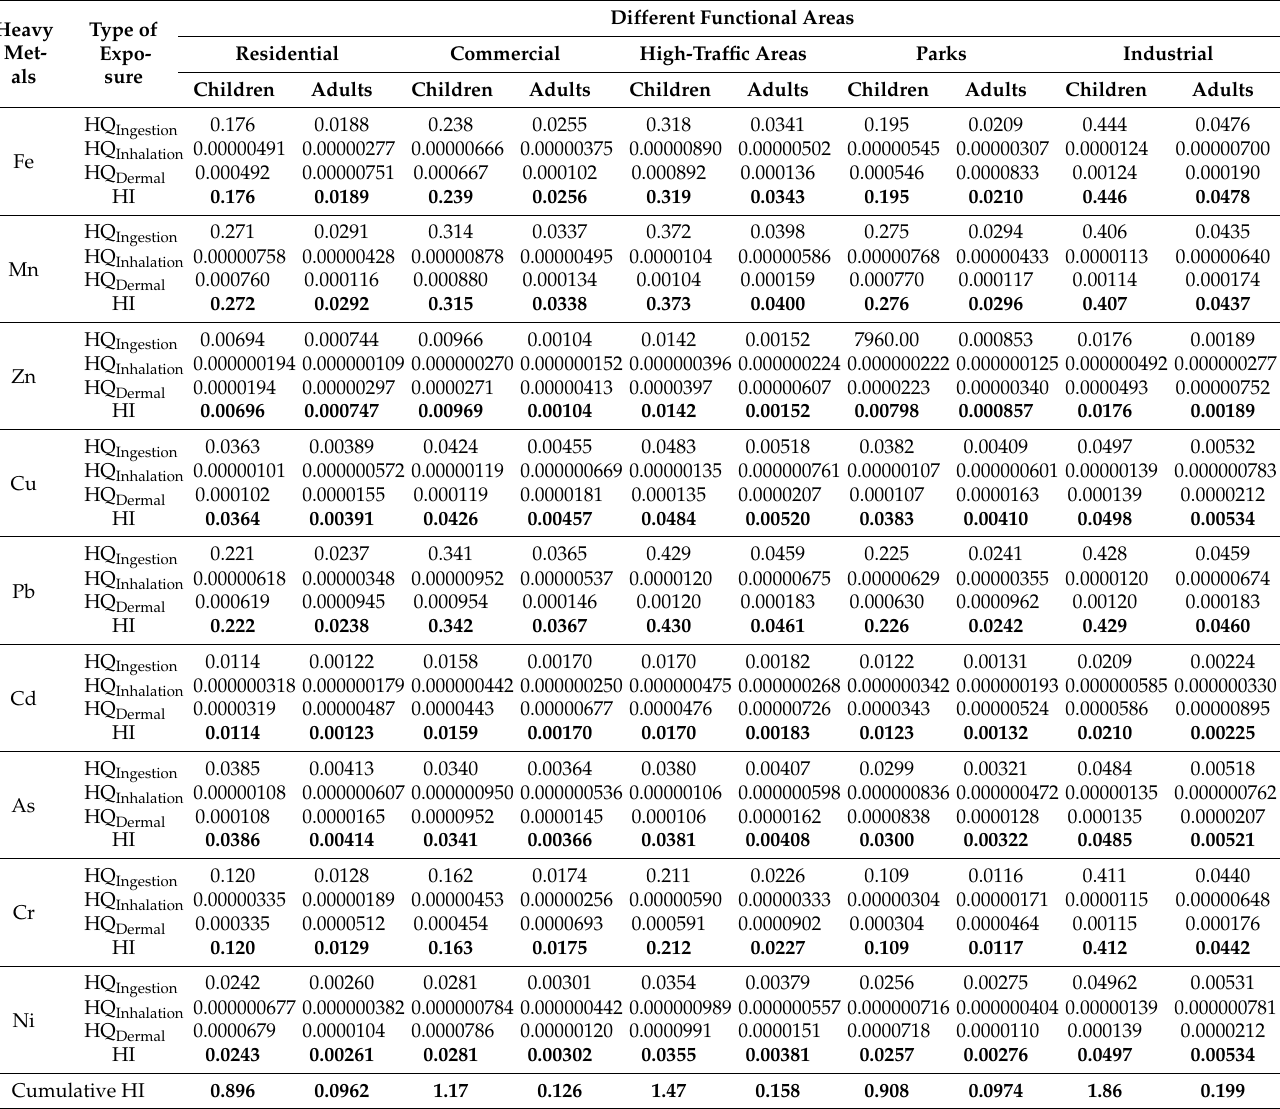
Table 8. Summary of hazard quotient (HQ) and hazard index (HI) values of HMs in road dust for five different functional